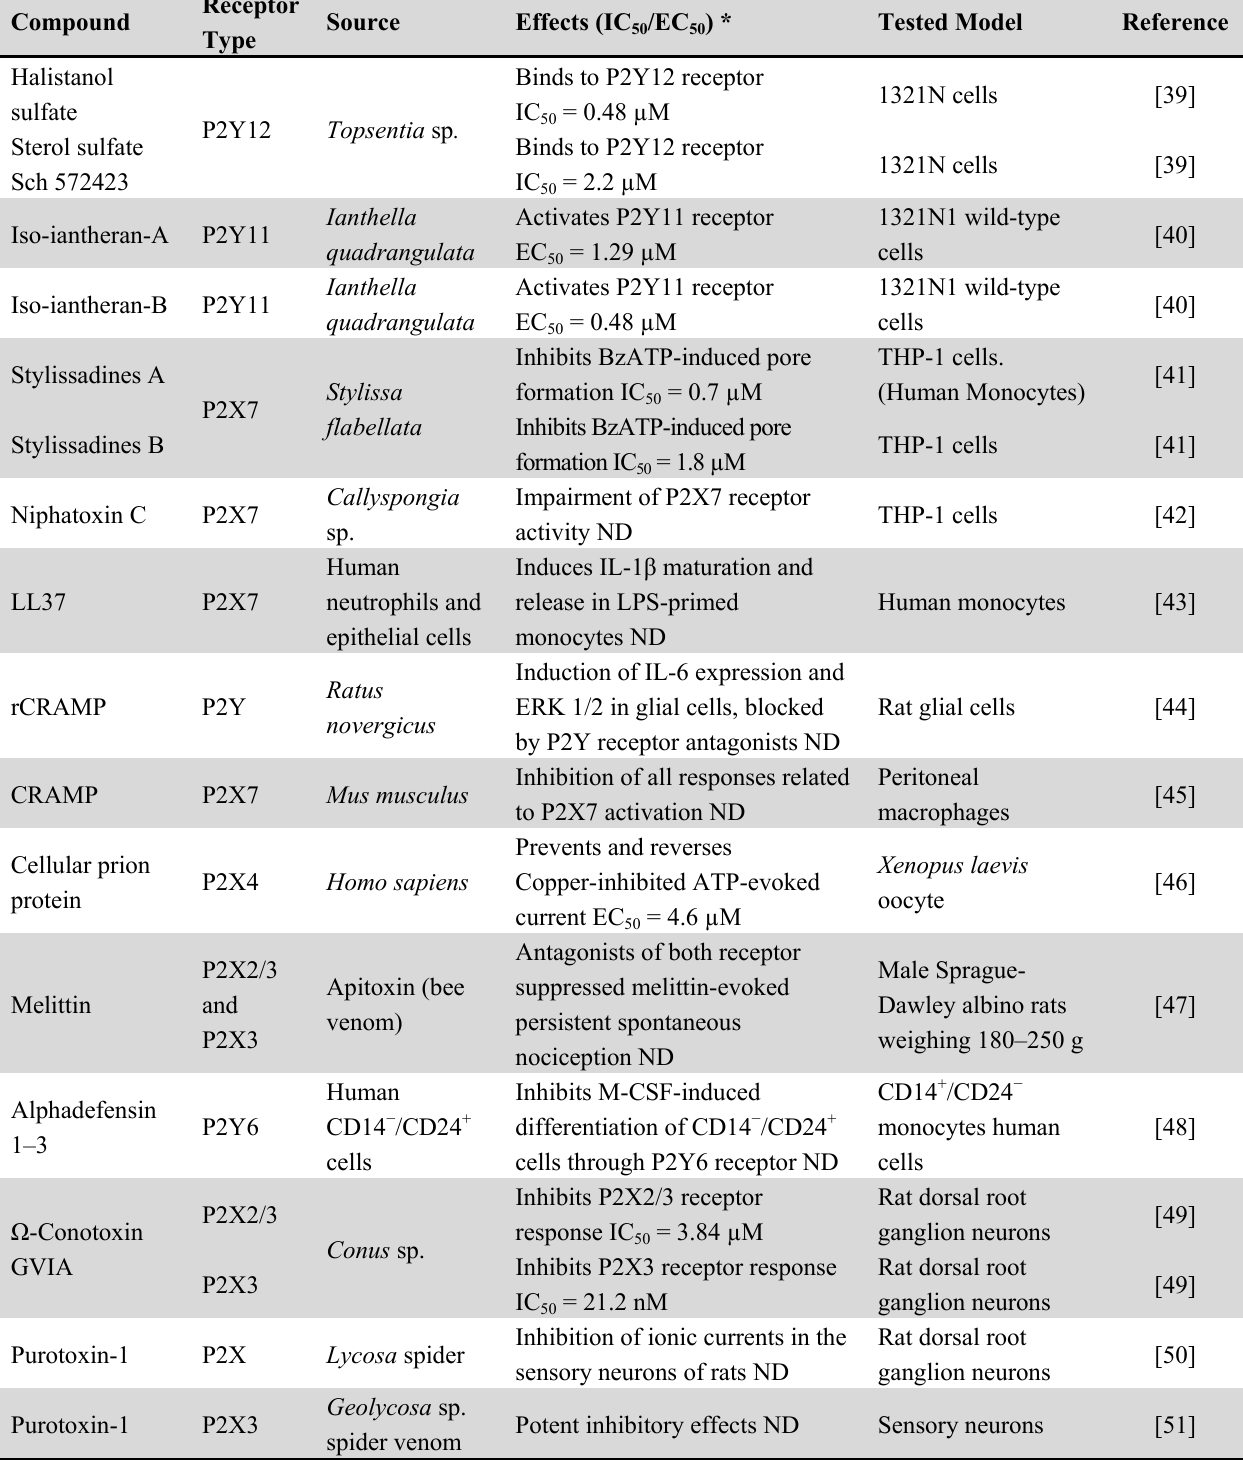
Table 2. Natural products from animal